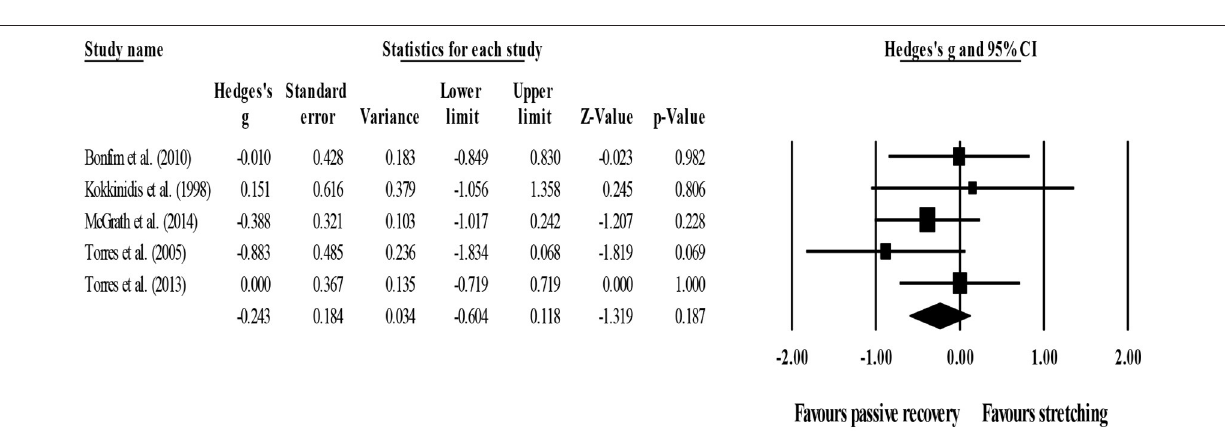
FIGURE 8 | Forest plot of changes in 24-h post-exercise delayed onset of muscle soreness (DOMS) after participating in post-exercise stretching protocols compared to control conditions (i.e., passive recovery). Values shown are effect sizes (Hedges’s g) with 95% confidence intervals (CI). The size of the plotted squares reflects the statistical weight of each study. The black diamond reflects the overall